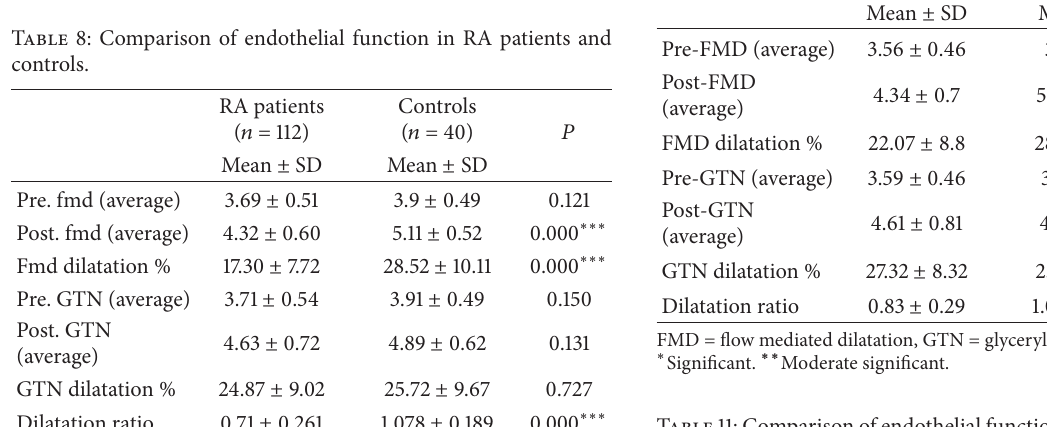
Table 11: Comparison of endothelial function in subdivisions of